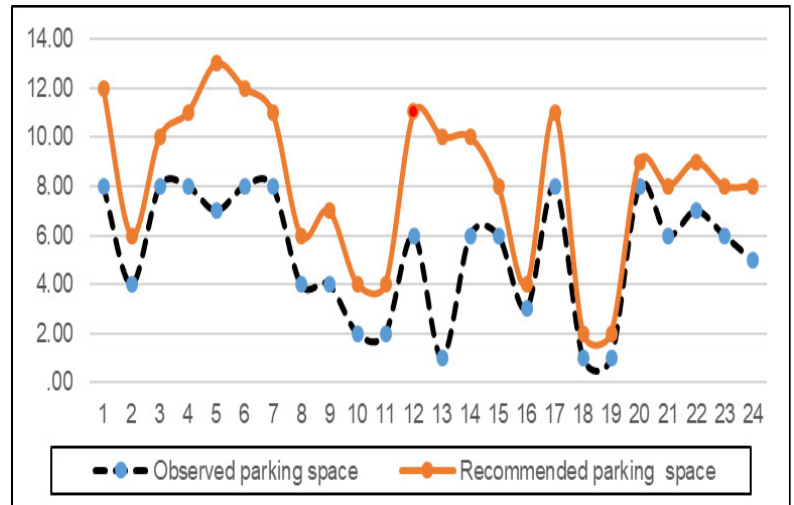
Fig. 4: Variations on the provision of car parking in Nyanchwa